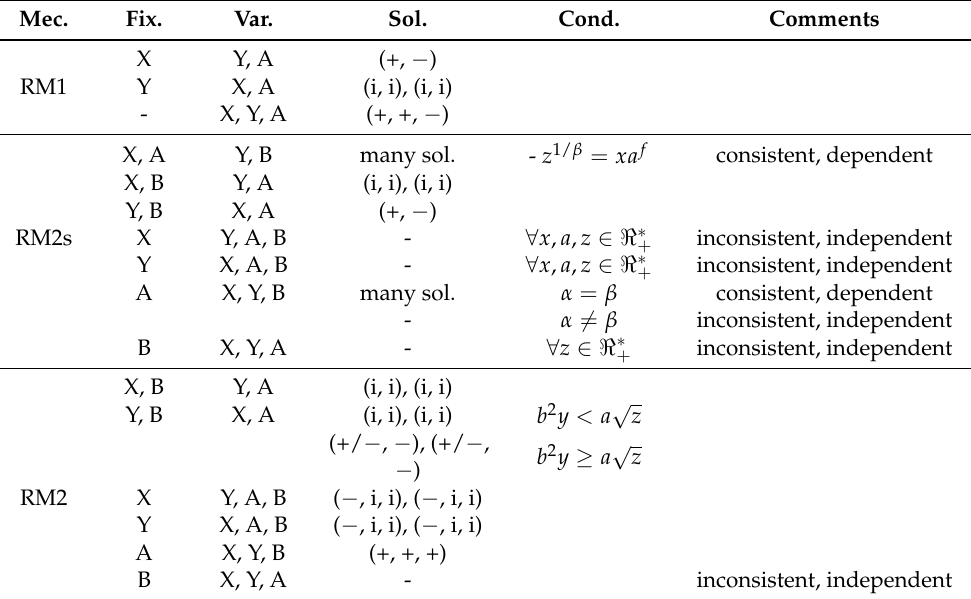
Table A4. Table of ODE classifications and solutions considering α = 2, β = 1, c = g = 1, and d = f = 2. Mec.